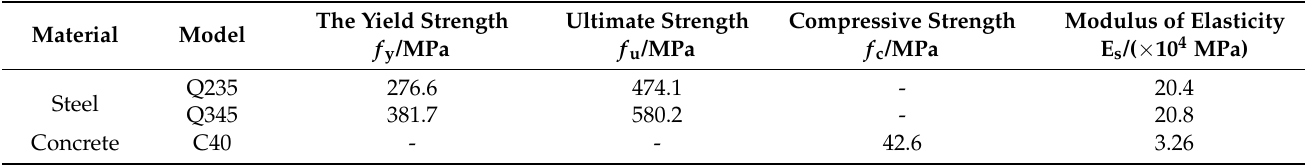
Figure 4. Experimental construction of precast assembled piers. Table 1. Material property test results.